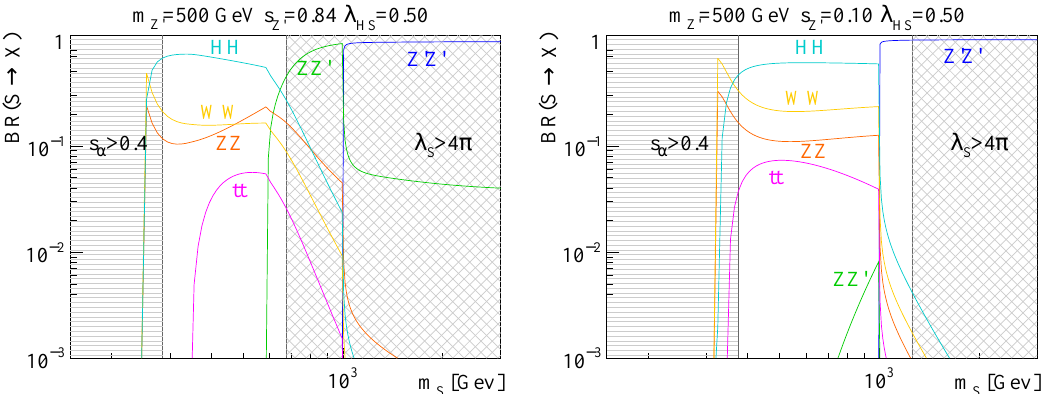
= 500 GeV, χ = 1 and Z (cid:48) . The hashed regions are HS